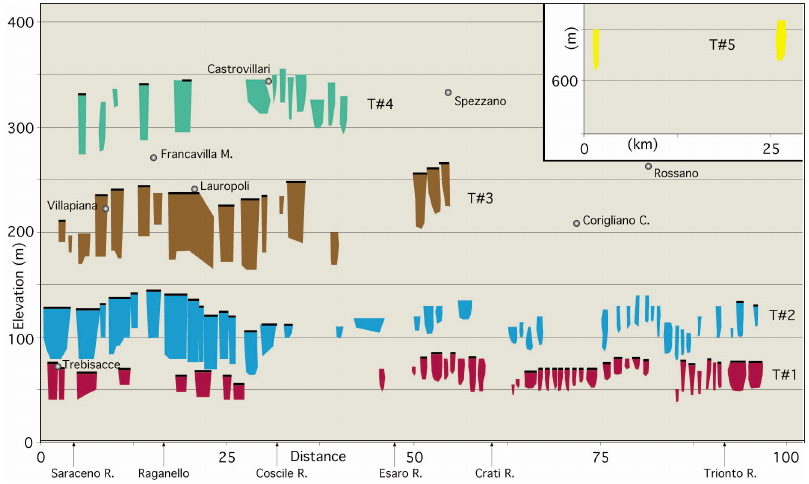
Fig. 3. Elevation profile of inner edges (black thick lines) and wavecut platforms (coloured areas) along a ver- tical section parallel to the coast.